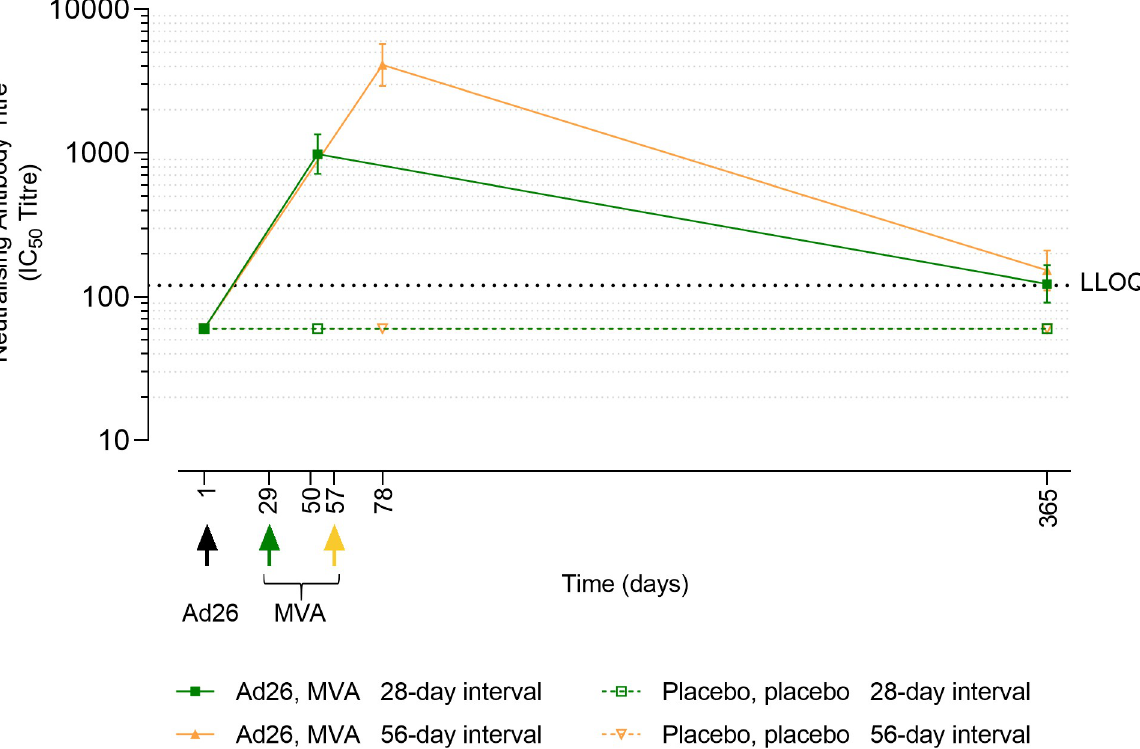
Fig 3. Anti-EBOV GP neutralising antibody responses in healthy adults. The error bars represent the GMT (IC 50 ) and its 95% CI. Subset of healthy adults administered with Ad26.ZEBOV on Day 1 and MVA-BN-Filo 28 or 56 days later as indicated. Responses in placebo groups are shown as open symbols. Black dotted line represents the LLOQ. Vaccines: Ad26 = Ad26.ZEBOV at a dose of 5 × 10 10 vp; MVA = MVA-BN-Filo at a dose of 1 × 10 8 Inf.U. CI, confidence interval; GMT, geometric mean titre; IC 50 , half maximal inhibitory concentration; LLOQ, lower limit of